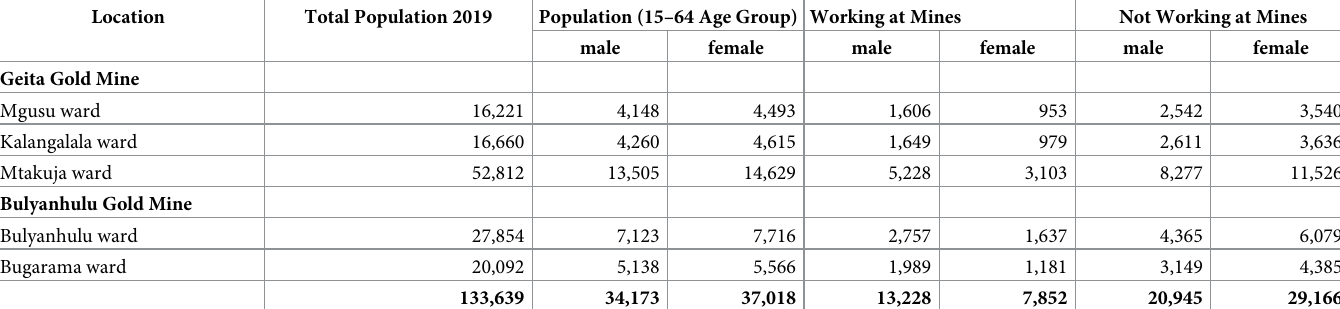
Table 1. Population under surveillance around Geita gold mine and Bulyanhulu gold mine.